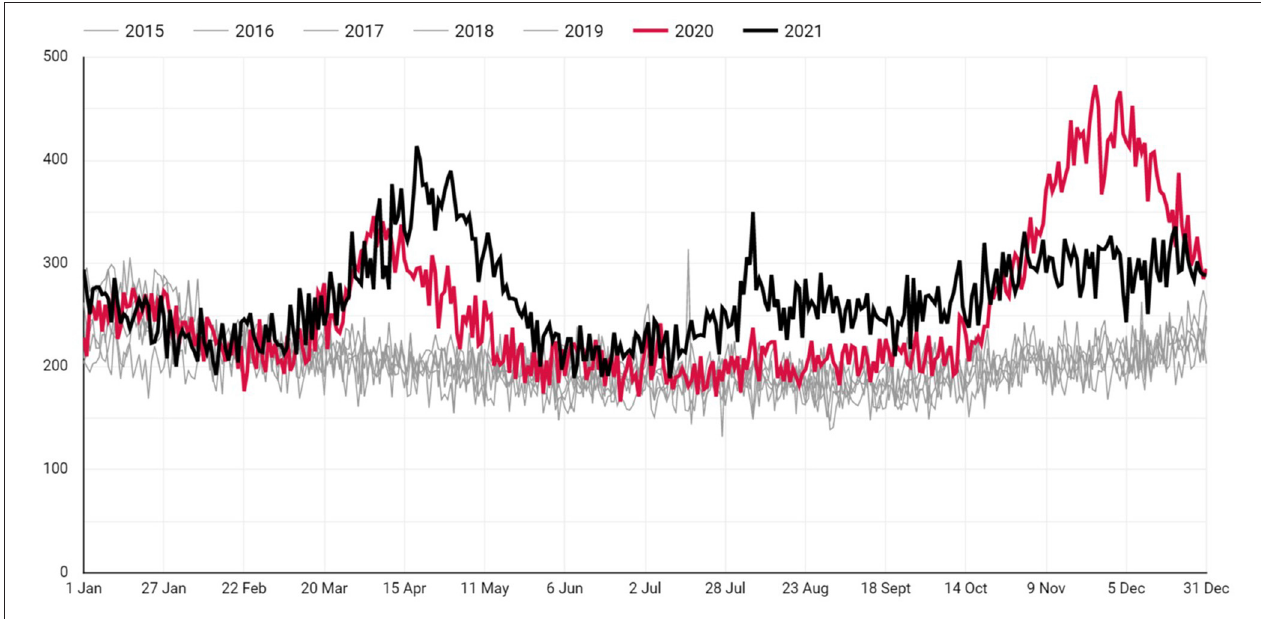
FIGURE 1 | The daily number of all cause deaths in Istanbul